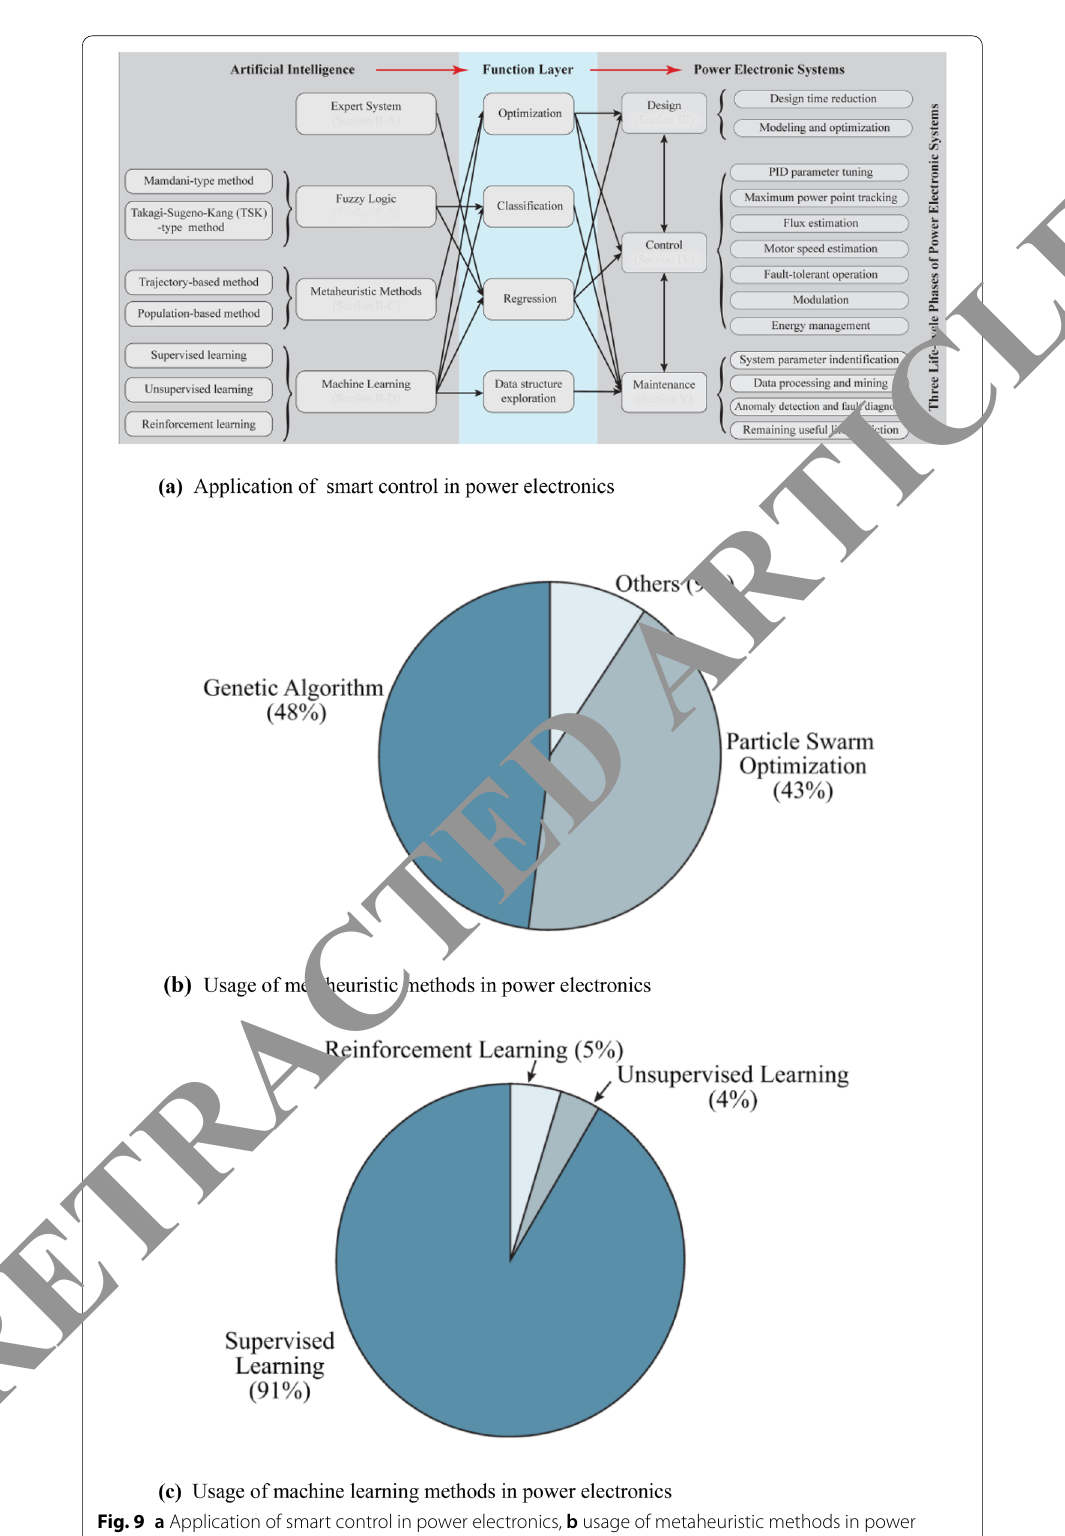
Fig. 9 a Application of smart control in power electronics, b usage of metaheuristic methods in power electronics, and c usage of machine learning methods in power